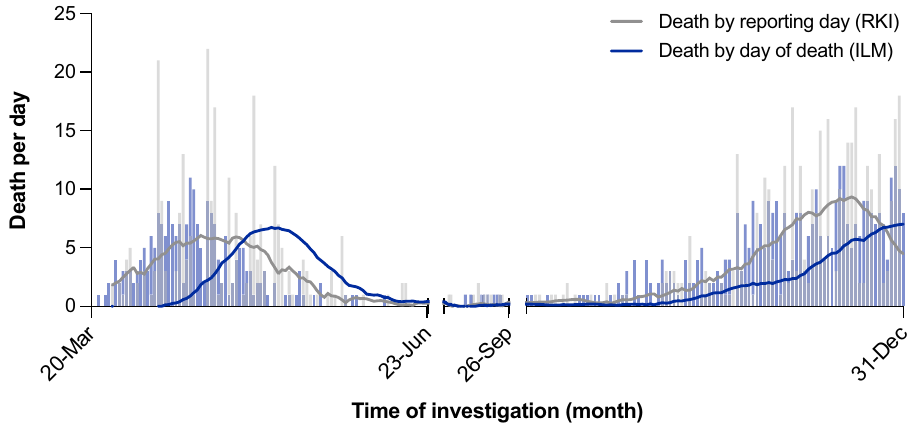
Figure 1. Reported SARS-CoV-2 associated deaths per day by the Robert Koch Institute (RKI) 9 in grey scales versus the reported COVID-19 deaths per day by the Institute of Legal Medicine (ILM) Hamburg in blue